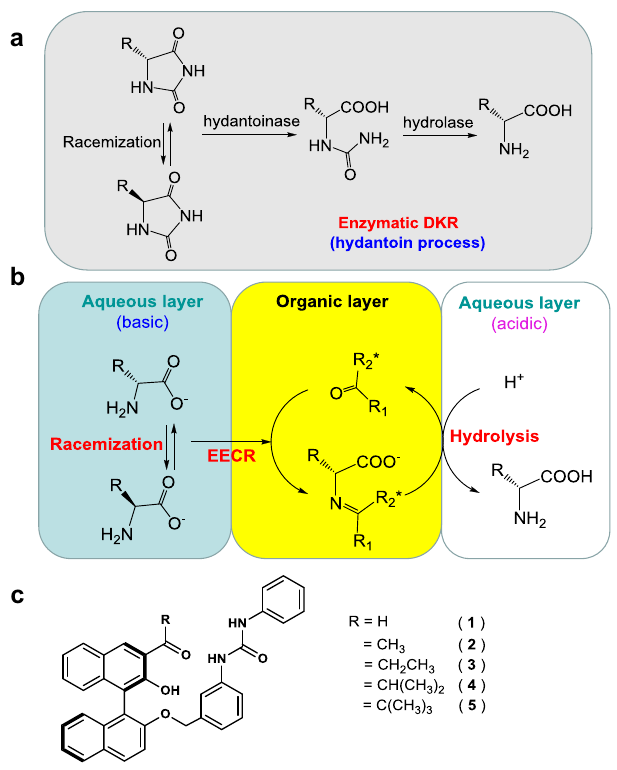
Fig. 1 Comparison of enzymatic DKR and EECR. a Hydantoin process, an enzymatic DKR. b Enantioselective extraction coupled with racemization (EECR). c Carbonyl compounds studied for EECR in this